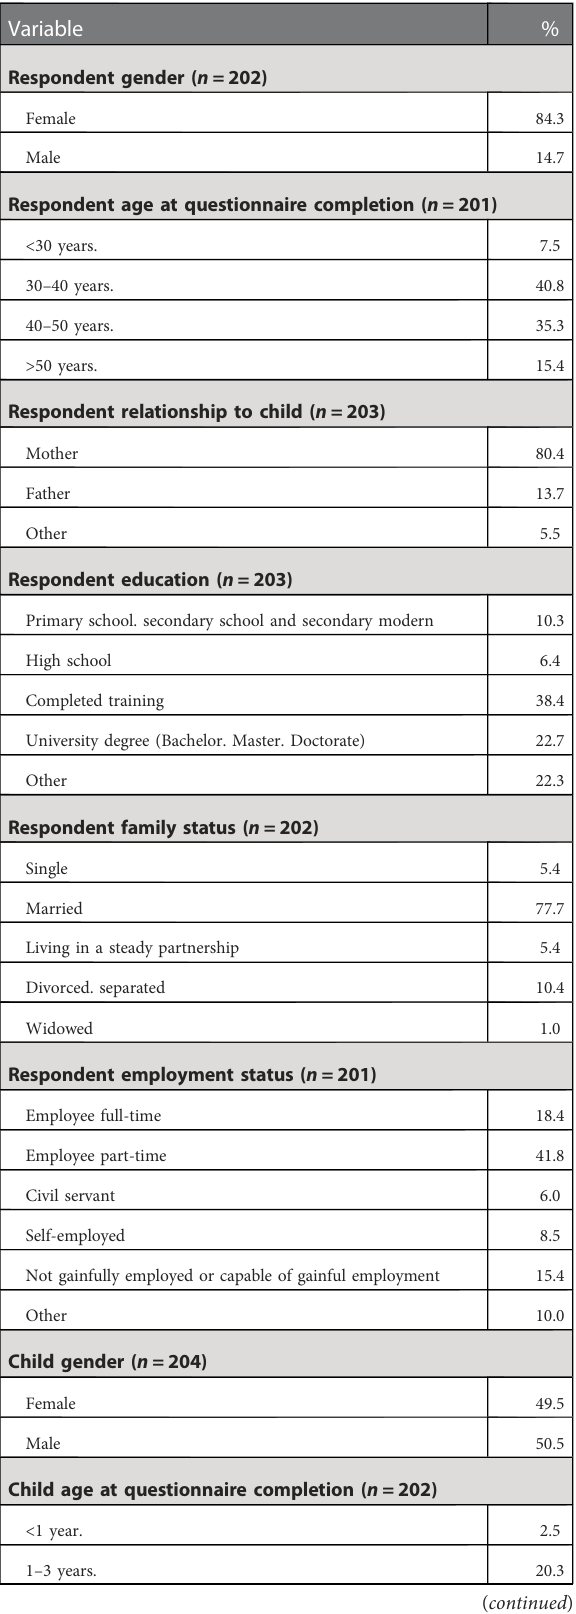
TABLE 2 Child and caregiver descriptive